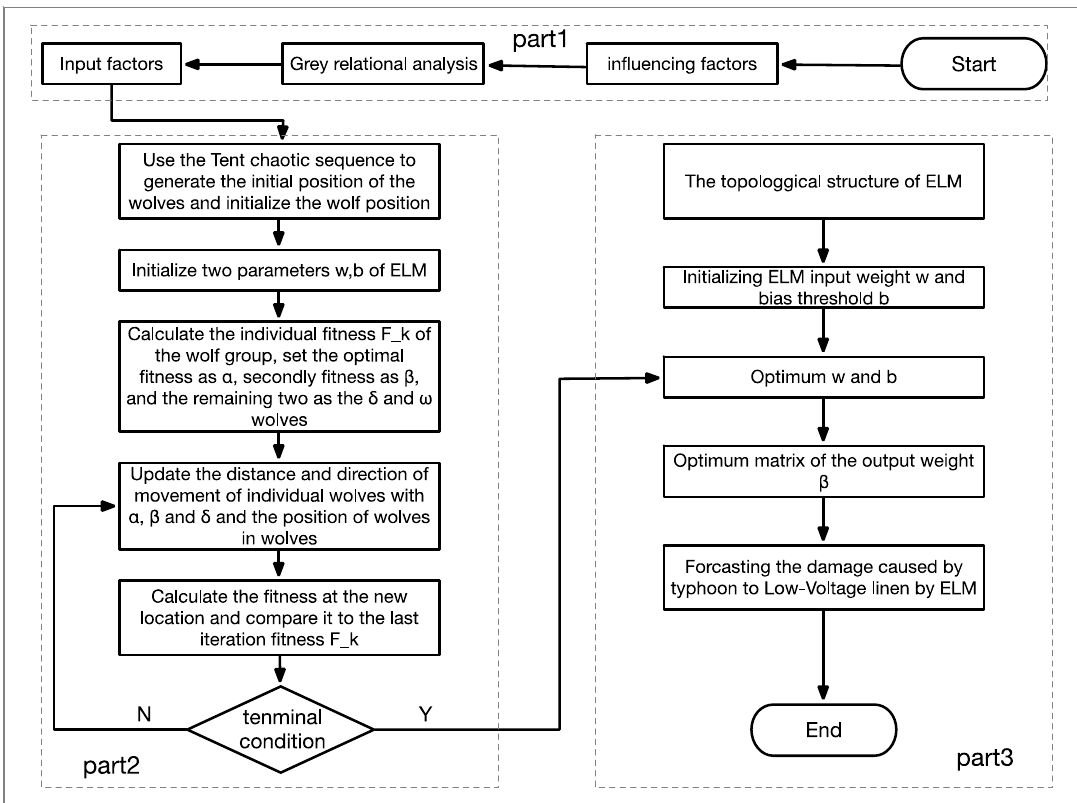
Figure 2. Extreme Learning Machine (ELM) model structure.